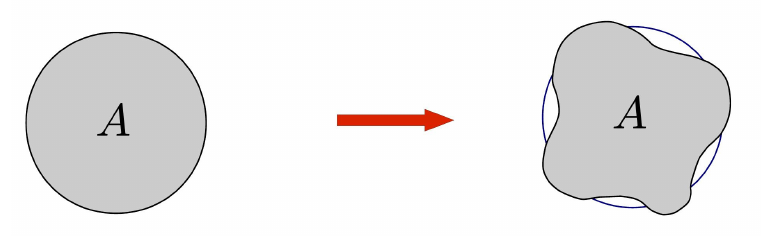
Figure 1 . Shape deformation of the droplet under the action of area preserving